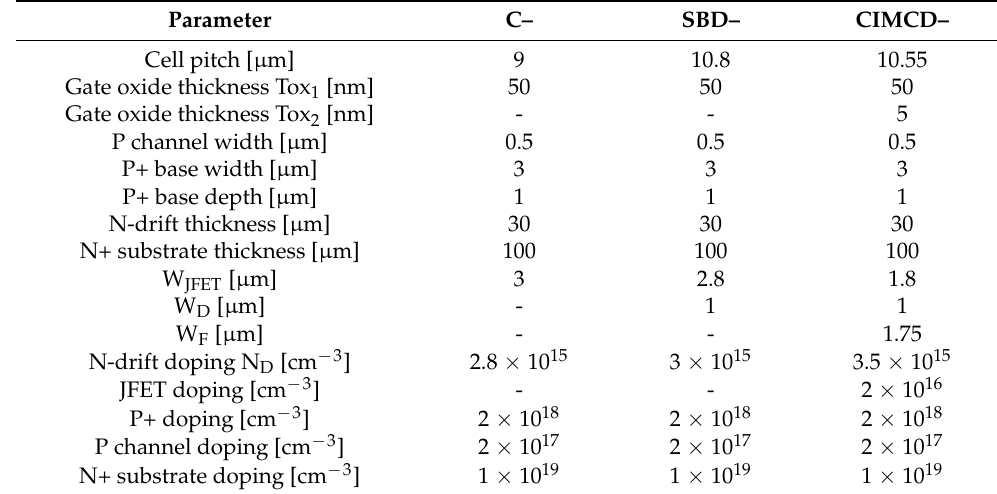
( b ) Figure 2. Comparison of the ( a ) B – FOM characteristics for WJFET and N D variation of CIMCD – MOSFET ( b ) third-quadrant characteristics for different WD of CIMCD – MOSFET.